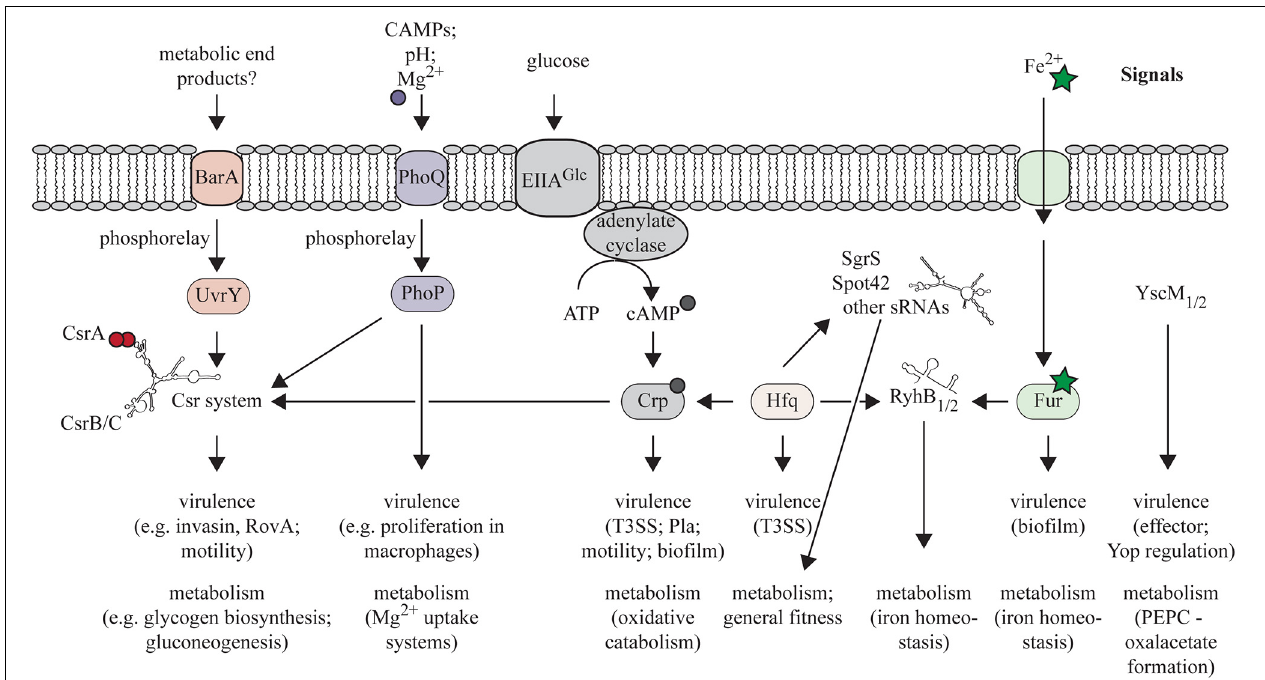
FIGURE 3 | Schematic overview of regulatory factors that are known to coordinate expression of metabolic functions but also virulence-associated traits in pathogenic Yersinia species. It should be noted that not all regulatory networks have been experimentally verified in all pathogenic yersiniae .